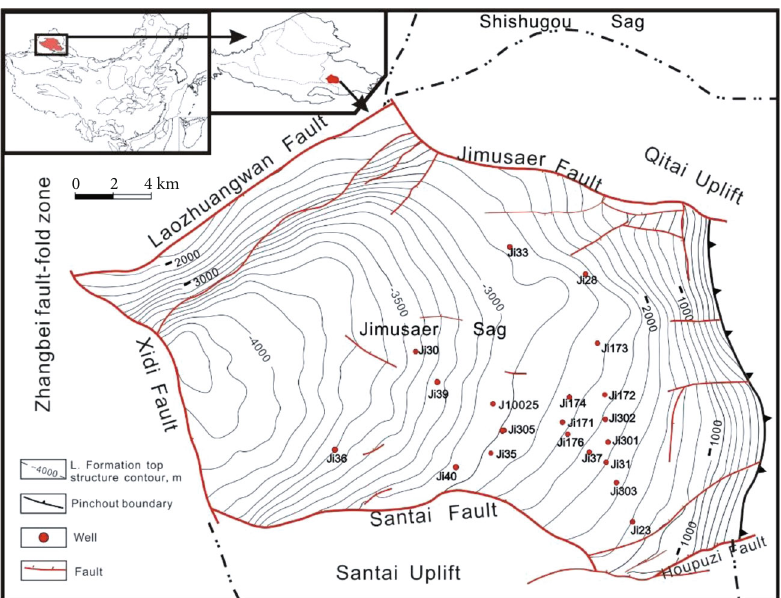
Figure 1: Structural location map of Jimusaer